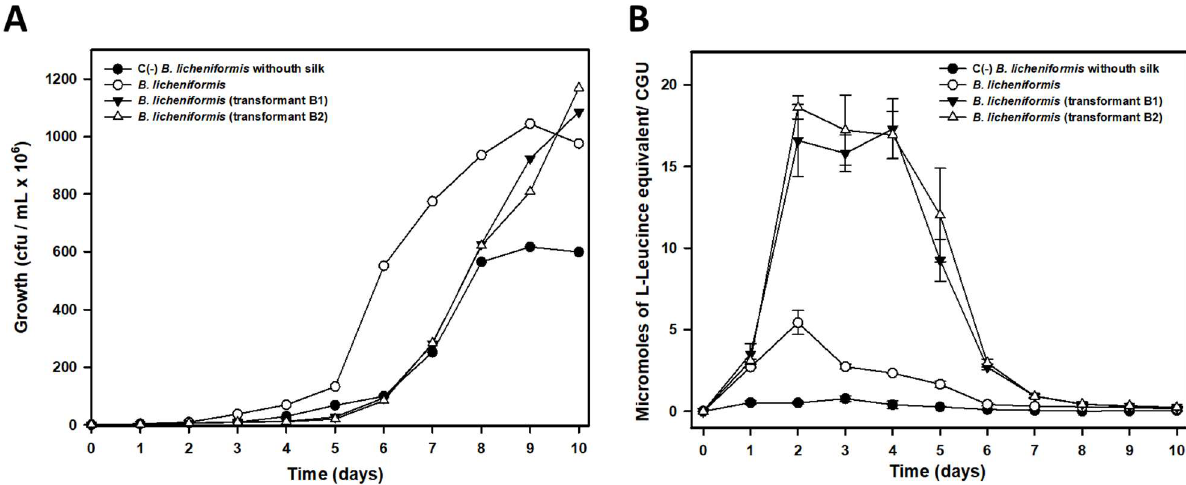
Figure 7. Stimulation of raw silk biodegradation in B. licheniformis B1 and B2 transformants carrying 8 copies (1 chromosomal copy and 7 plasmid copies) of the sub C gene compared to the biodegradation rate observed in the wild-type strain IIVV-SD3 carrying a single chromosomal copy of the sub C gene. ( A ) Growth rate estimated as viable cells or cfu/mL. ( B ) Release of L-Leucine equivalent (μmol) into the culture media from silk biodegradation. Given the different growth rates observed in the transformants compared to the wild-type IIVV-SD3 strain, the results were normalized to the number of viable cells (cfu) detected in the cultures and expressed as CGUs (Cellular Growth Units). One CGU equals 1 × 10 7 viable cells. The results shown are the average of two different experiments performed in triplicate.